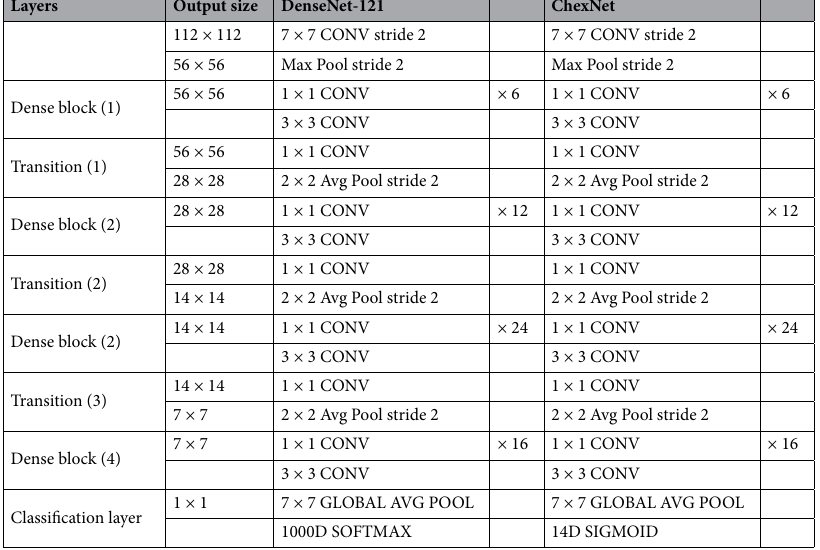
Table 1. The layer comparison DenseNet-121 and